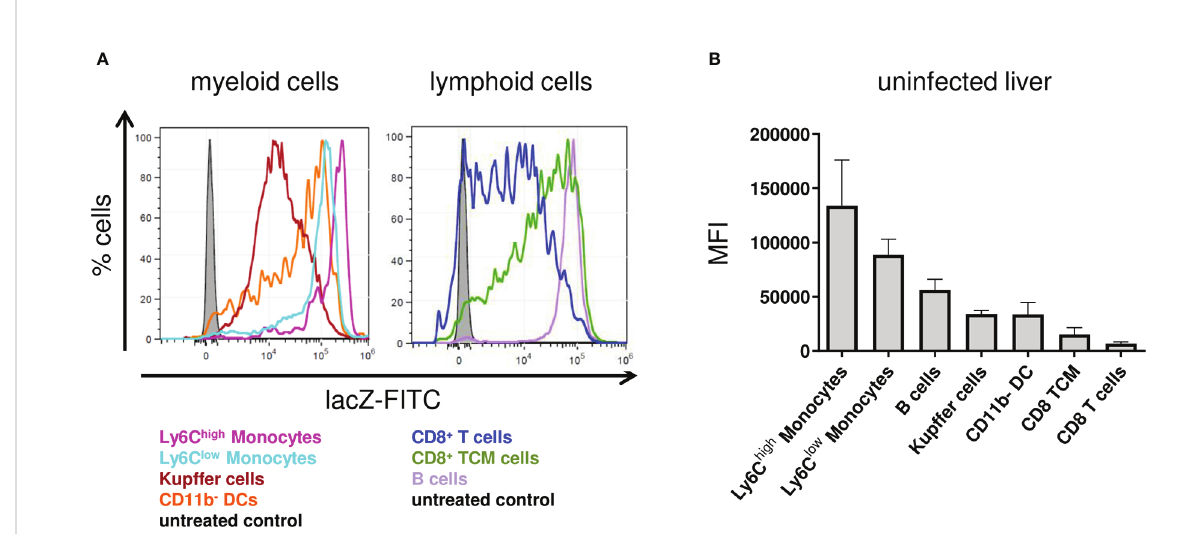
FIGURE 2 Nfkbid promoter activity in different immune cell subsets in the liver of Nfkbid lacZ reporter mice. Nfkbid lacZ reporter mice (n = 4) were sacri fi ced, livers were sampled and total leukocytes were isolated. FACS analyses for the differentiation of stated immune cells subsets was performed together with intracellular lacZ FDG reporter assay. (A) Representative histogram overlays of fl uorescein reporter fl uorescence intensities in myeloid (left) and lymphoid (right) cellular subsets. (B) Numeric representation of fl uorescein reporter fl uorescence intensities. Data represent mean ± SD of median fl uorescence